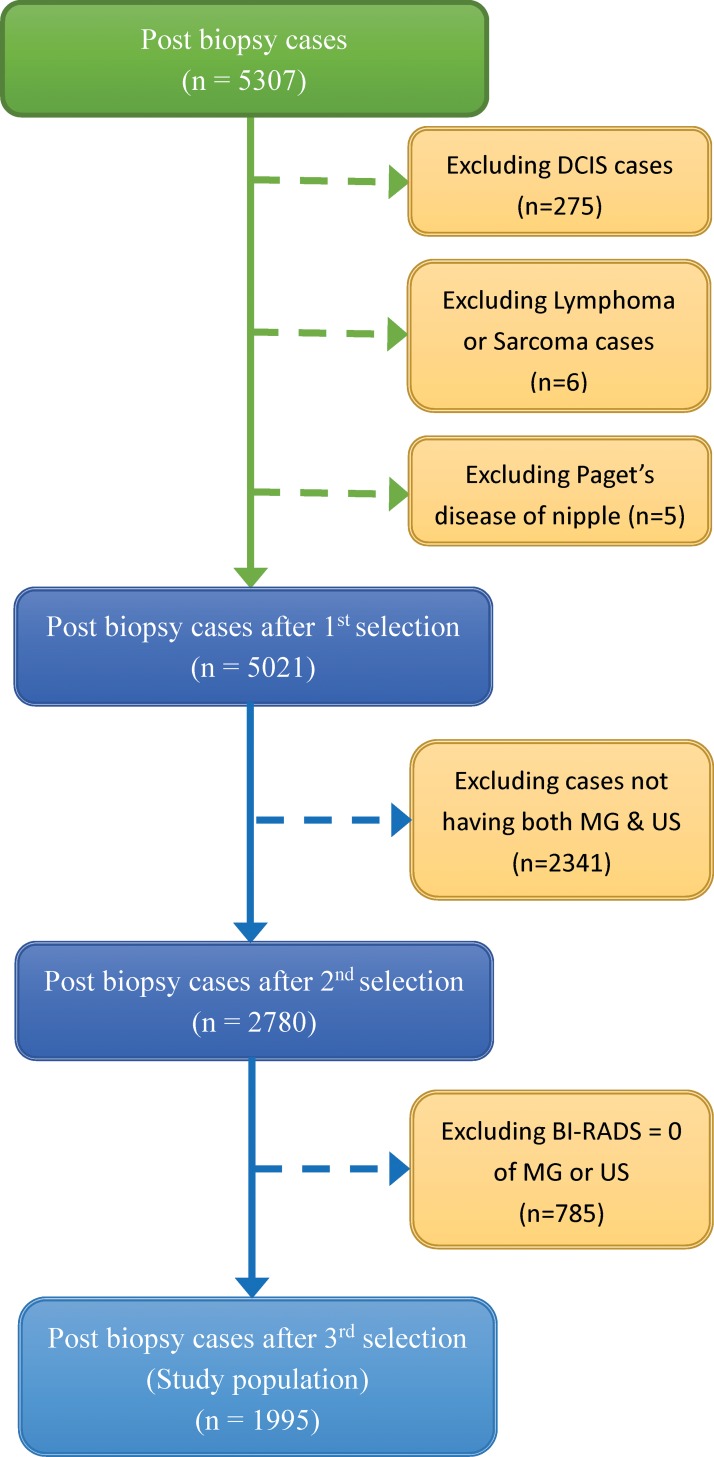
Flow chart of summarizing patient selection.